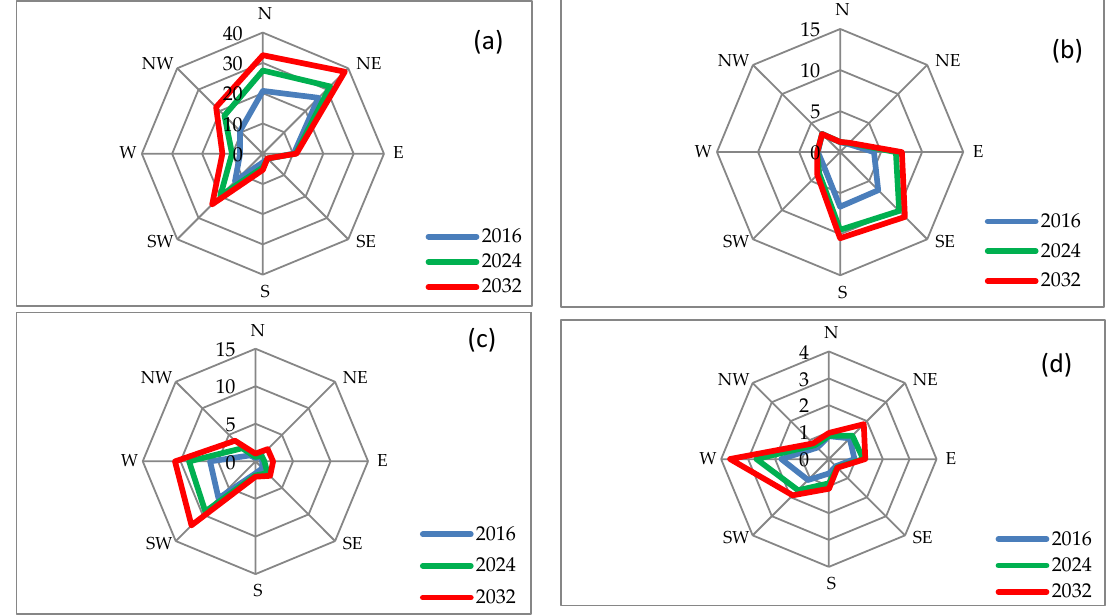
Figure 9. Simulation of urban orientation: ( a ) Kathmandu; ( b ) Lalitpur; ( c ) Bhaktapur; and ( d ) Kabhrepalanchok.